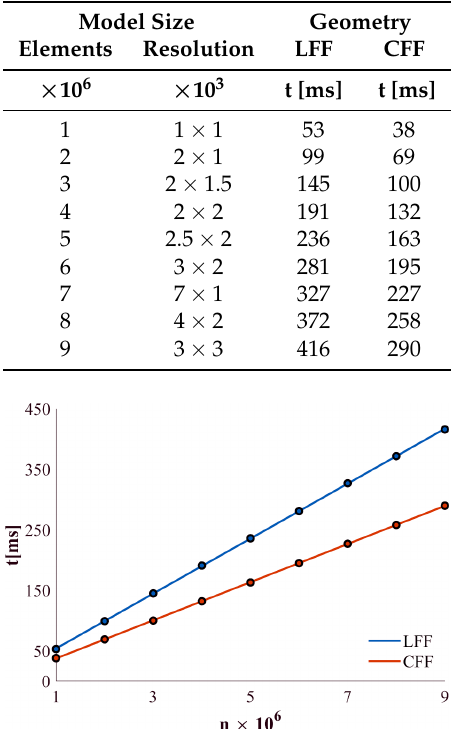
Table 2. Computational efficiency of the CFF method depending on the model size compared to the LFF variant.